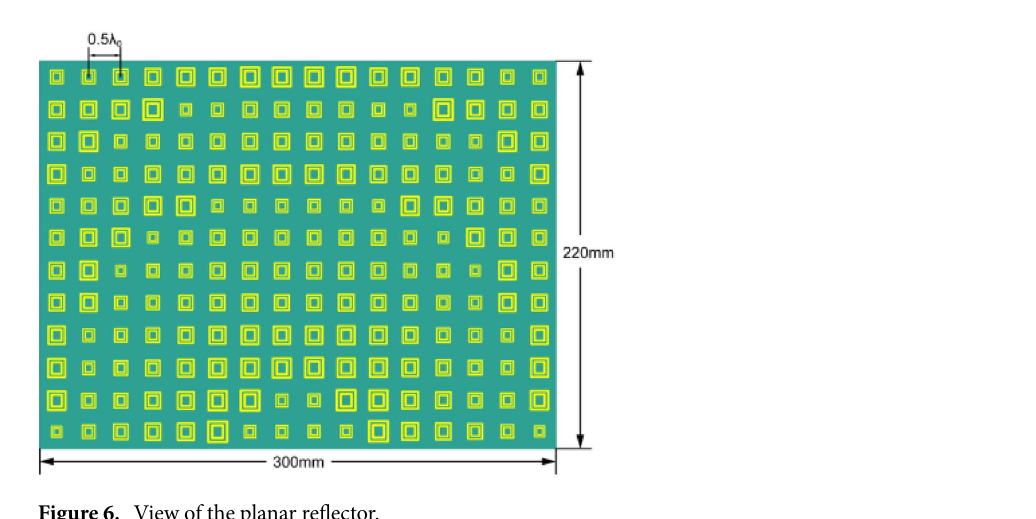
Figure 6. View of the planar